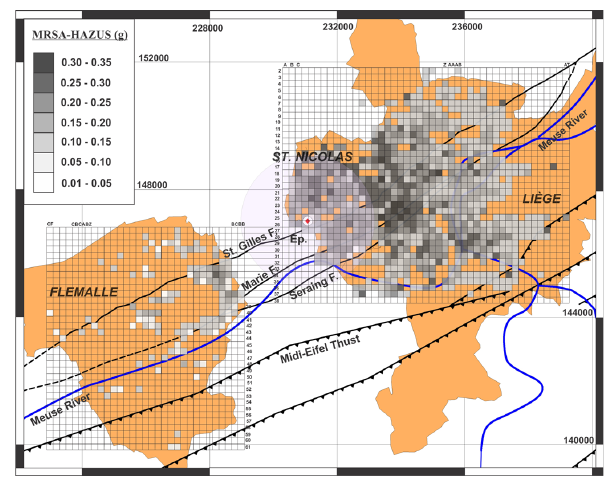
Fig. 7. Percentage of buildings presenting moderate or greater dam- ages (% D ≥ MD) after the 1983 Li`ege earthquake calculated for square areas of 0.040km 2 over the localities of Saint Nicolas, Li`ege and Fl´emalle. Projections: Belgian Lambert 72.